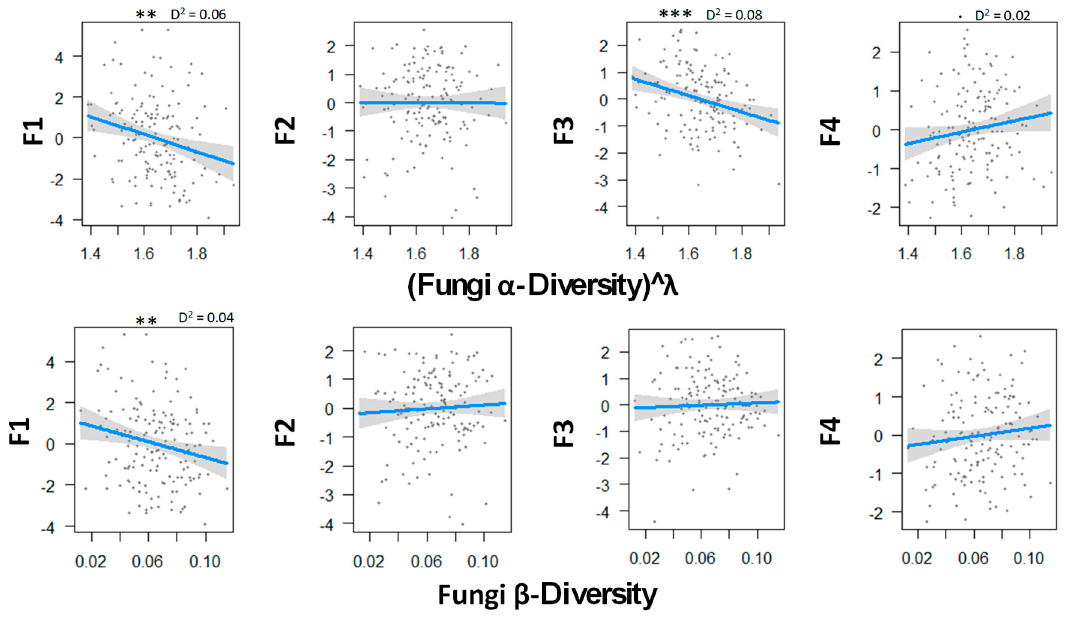
Figure 2. Relations between fungal α - and β -biodiversity and the ecosystem functions analyzed by GLM and a Gaussian law grouped with PCA axes. Transformation parameter λ was equaled to 0.10 for fungal α -diversity. Thresholds of significance are as follows: 0 '***' 0.001 '**' 0.01 '*' 0.05 '.' 0.1 '' 1. D 2 represents the adjusted amount of deviance for GLM ( Dsquared function in modEvA package v1.3.2,). Even though it explains only 8.0% of the variance, fungal α -diversity explains best the N cycle. n = 156 .